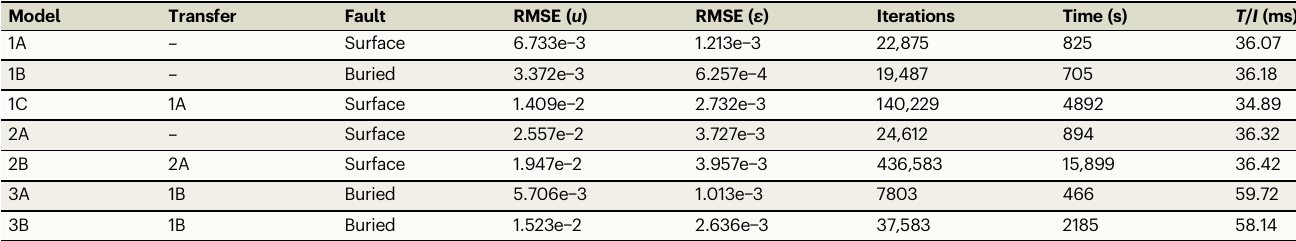
Table 1 | Model structures, root-mean-square errors (RMSEs), and computational costs Model